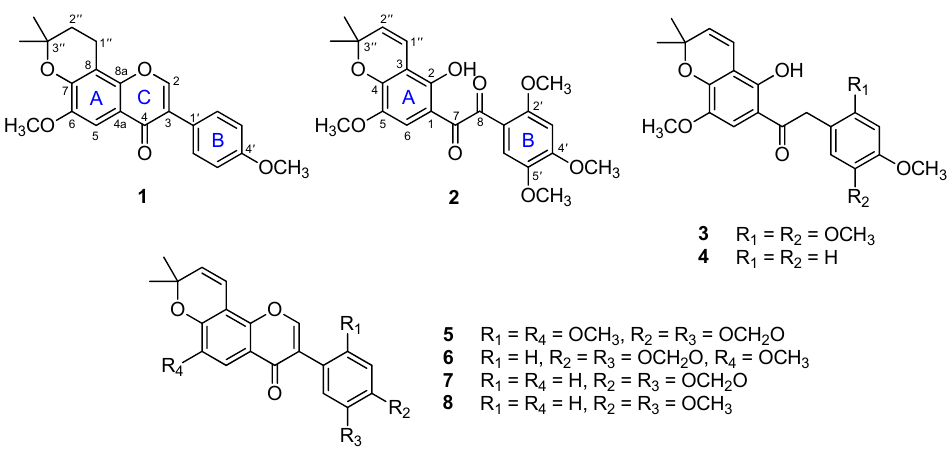
Figure 1. Chemical structures of 1 ‒ 8 .